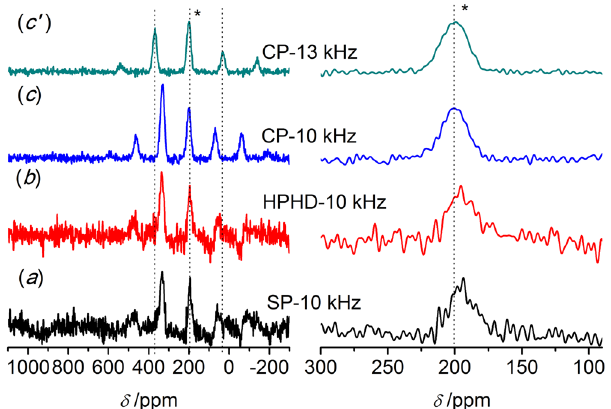
Figure 4. 77 Se MAS NMR spectra of polymer 4 (-Se-CH 3 ) obtained by different pulse sequences. ( a ) Single pulse (SP); ( b ) High power 1 H decoupling (HPHD); ( c, c ′ ) Cross polarization (CP), 17408 scans and the spinning speed of 10 kHz or 13 kHz. The isotropic peak is labeled with an asterisk ( *